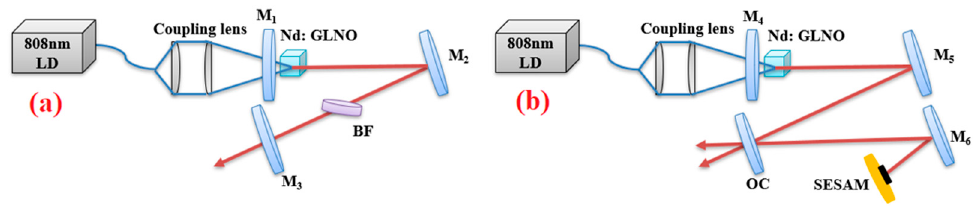
Figure 1. Schematic setups of the Nd:GLNO laser, ( a ) tunable operation; ( b ) CW mode-locking operation.